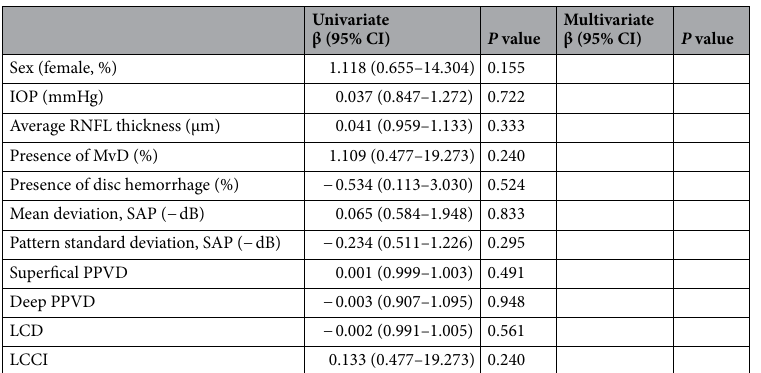
Table 4. Factors associated with the SAP–FDT difference using logistic regression analysis in peripheral nasal step. CI confidence interval, IOP intraocular pressure, RNFL retinal nerve fiber layer, MvD microvascular dropout, SAP standard automated perimetry, PPVD peripapillary vessel density, LCD lamina cribrosa depth, LCCI lamina cribrosa curvature index. Variables with P < 0.10 were included in the multivariate analysis.